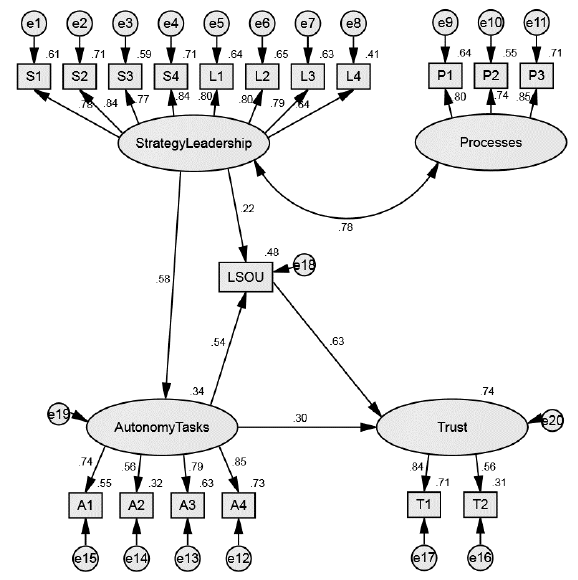
Figure 2. Structural equation model.